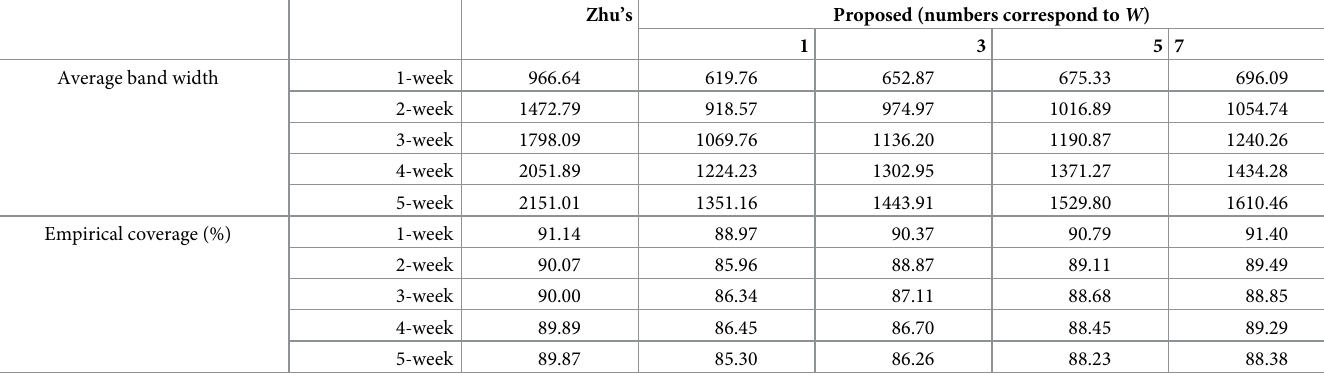
Table 4. Average bandwidth and empirical coverage of the 95% prediction interval found using the proposed method and Zhu’s method. Zhu’s Proposed (numbers correspond to W